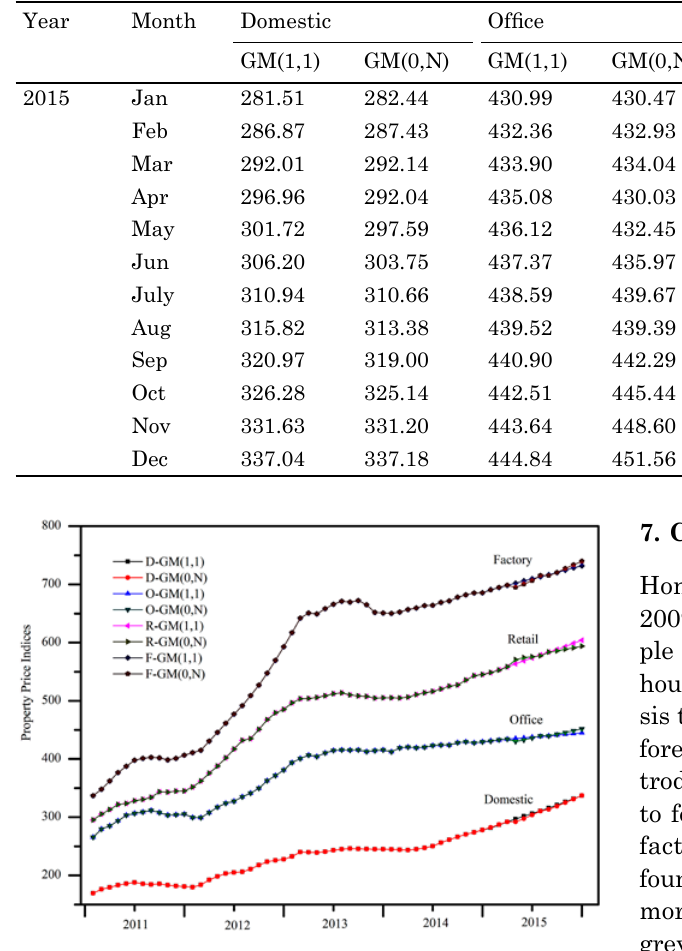
Table 6. Forecast of property price indices of 2015